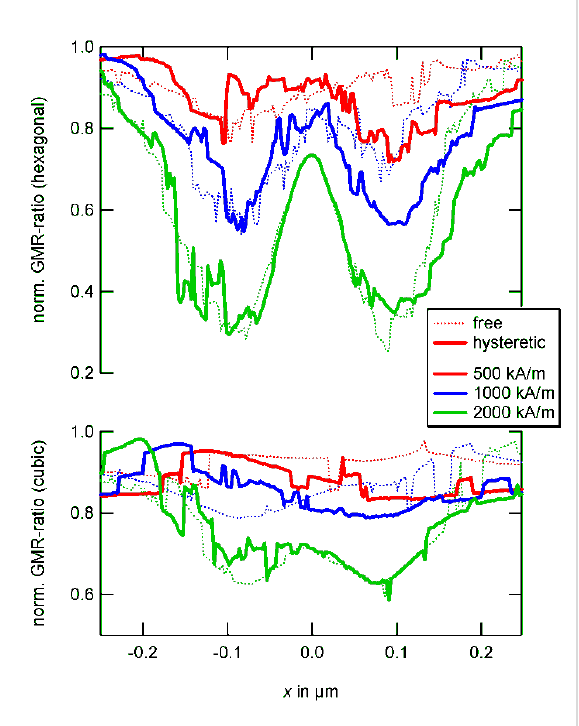
Figure 20: Comparison between free (dotted) and hysteretic (line) sensor behavior for cubic and hexagonal symmetries. Due to stable vortex-like states, the overall effect is smaller for the cubic assemblies. For high particle moments, hysteretic and non-hysteric responses show only small